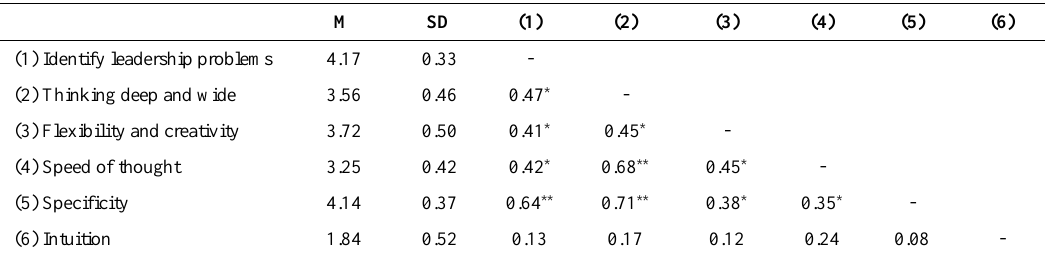
Table 7. Pearson correlation between manifestations of leadership